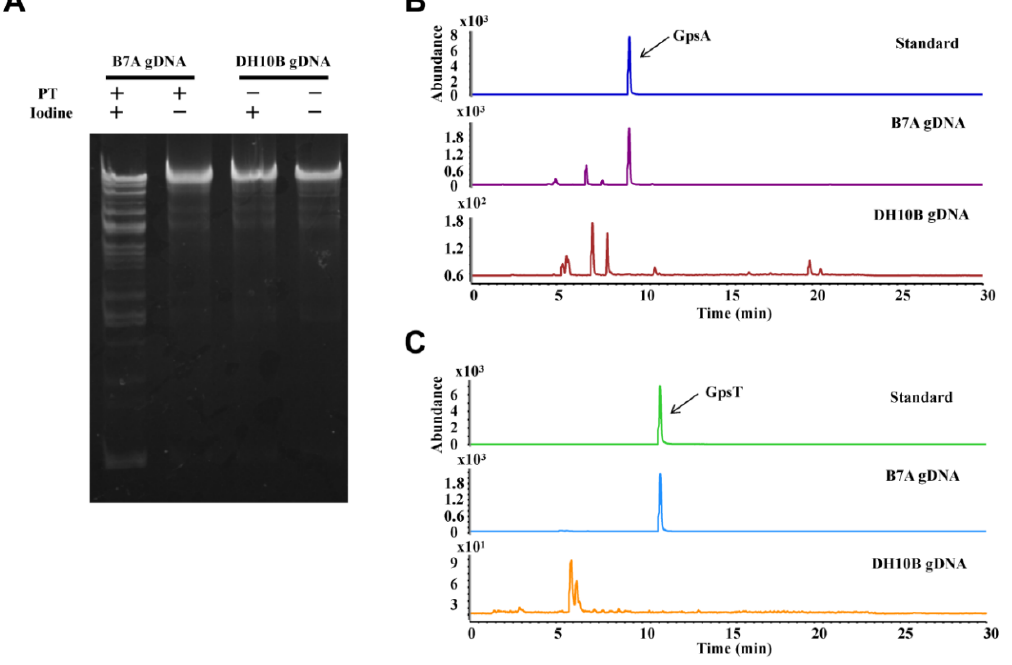
Figure 2. The detection of PT modification. ( A ) ICA analysis of gDNA. Lanes 1–2, genomic DNA from E. coli B7A with (+) or without (-) iodine. Lanes 3–4, genomic DNA from E. coli DH10B with (+) or without (-) iodine. ( B ) and ( C ) LC-MS/MS analysis of the PT-linked dinucleotides from E. coli B7A and from E. coli DH10B. The PT-modified dinucleotide (GpsA or GpsT) was used as standards.